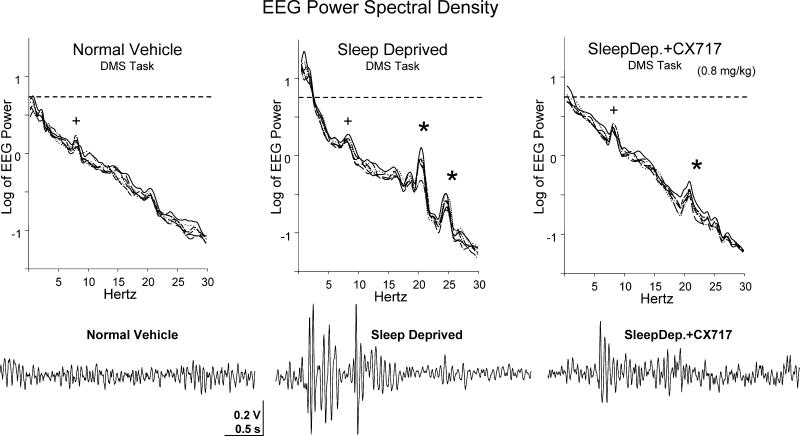
EEG and PSD Measures in Sleep-Deprived MonkeysMeasures superimposed (n = 4) are average PSD (upper graphs) and individual sample EEGs (lower tracings), recorded from electrodes placed over the parietal cortex, shown for three different treatment conditions (left, normal vehicle; middle, sleep deprivation; and right, sleep deprivation + CX717).In the graphs (upper) are shown PSDs for EEGs recorded from animals performing the DMS task. Sleep deprivation condition (middle) shows increased power of high-amplitude, slow-wave delta band (0.5–5 Hz, above dotted line) and two prominent peaks in the beta band (18–25 Hz) at 20 and 25 Hz (asterisks) relative to the normal vehicle condition (left). Reduction of sleep deprivation features of PSD in same animals following administration of CX717 (0.8 mg/kg) is indicated at right by a decrease in PSD delta band (0.5–5 Hz, dotted line) and reduction in power of peaks (asterisks) in the beta band (18–25 Hz). PSDs were calculated as log of root-mean-square power in 10-min segments of EEG recordings, using frequency increments of 0.25 Hz, plotted separately for four monkeys in each condition (individual traces).In the tracings (lower) are shown EEG segments (4.0 s) recorded from one of five electrode locations on the surface of the parietal cortex to demonstrate different EEG frequencies present in each condition. Traces correspond to the respective DMS testing sessions shown in the PSD plots above.DOI: 10.1371/journal.pbio.0030299g006